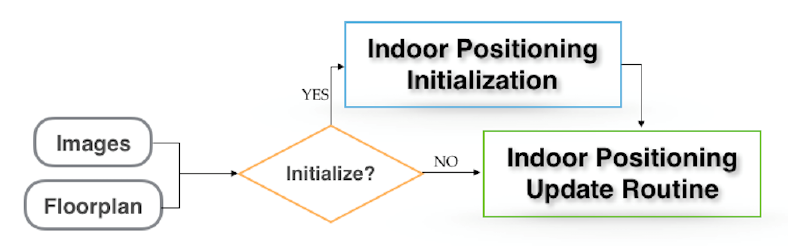
Figure 1. Positioning system flow